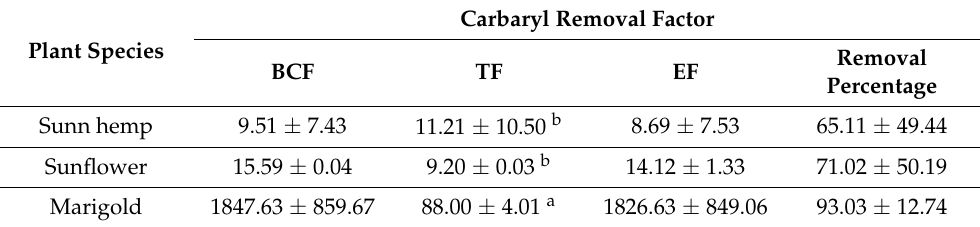
Table 2. Carbaryl removal parameters in flower plants after 4 days of cultivation for carbaryl treatment at 10 mg L − 1